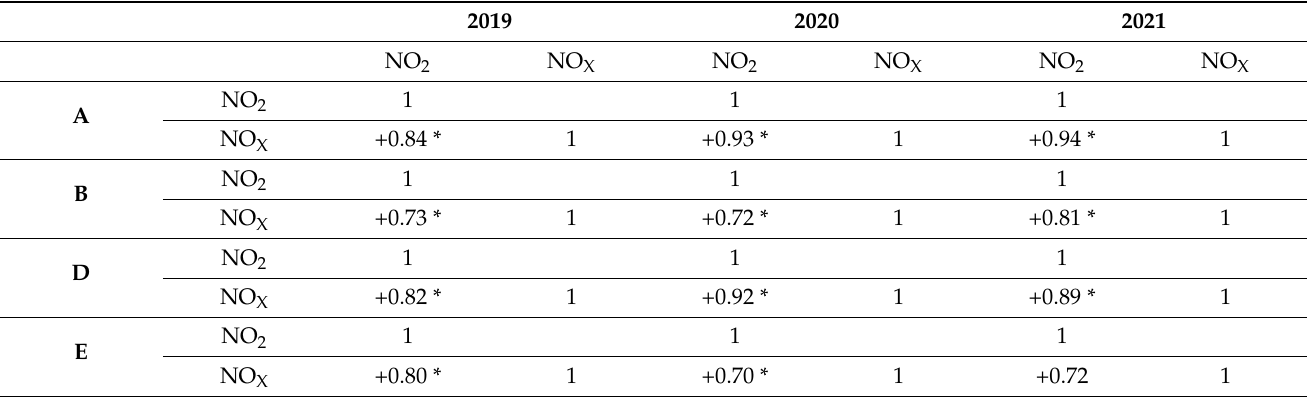
Table 3. Correlation between nitrogen